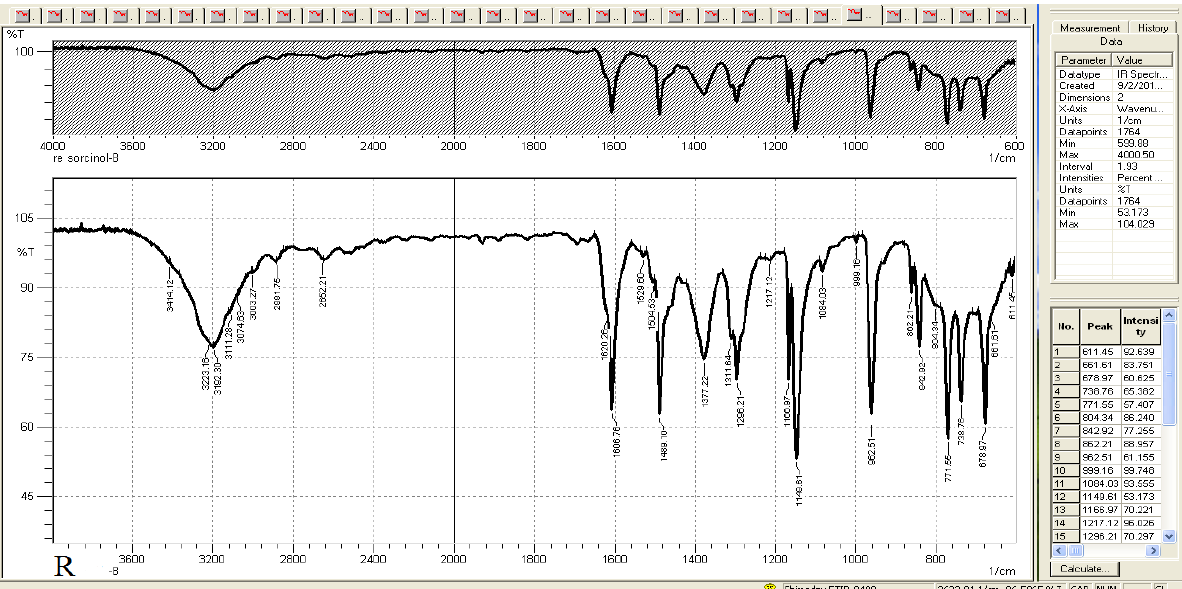
Figure15. FTIR spectrum of separated resorcinol. Melting